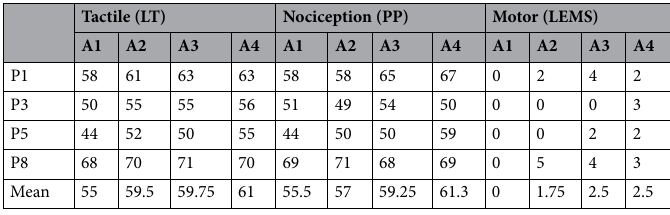
Table 1. Clinical scores for the LOC subgroup.